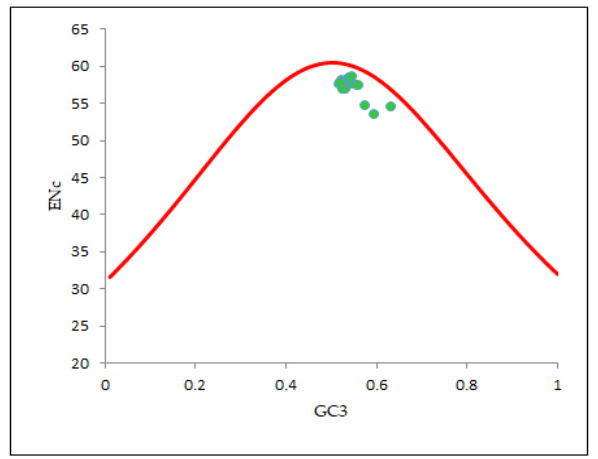
Figure 6. ENc-GC3 plot (selection curve) analysis. ENc denotes the effective number of codons and GC3s denotes the GC content in the third synonymous codon position. The red line curve represents the expected curve when the codon usage was only determined by the GC3 composition.